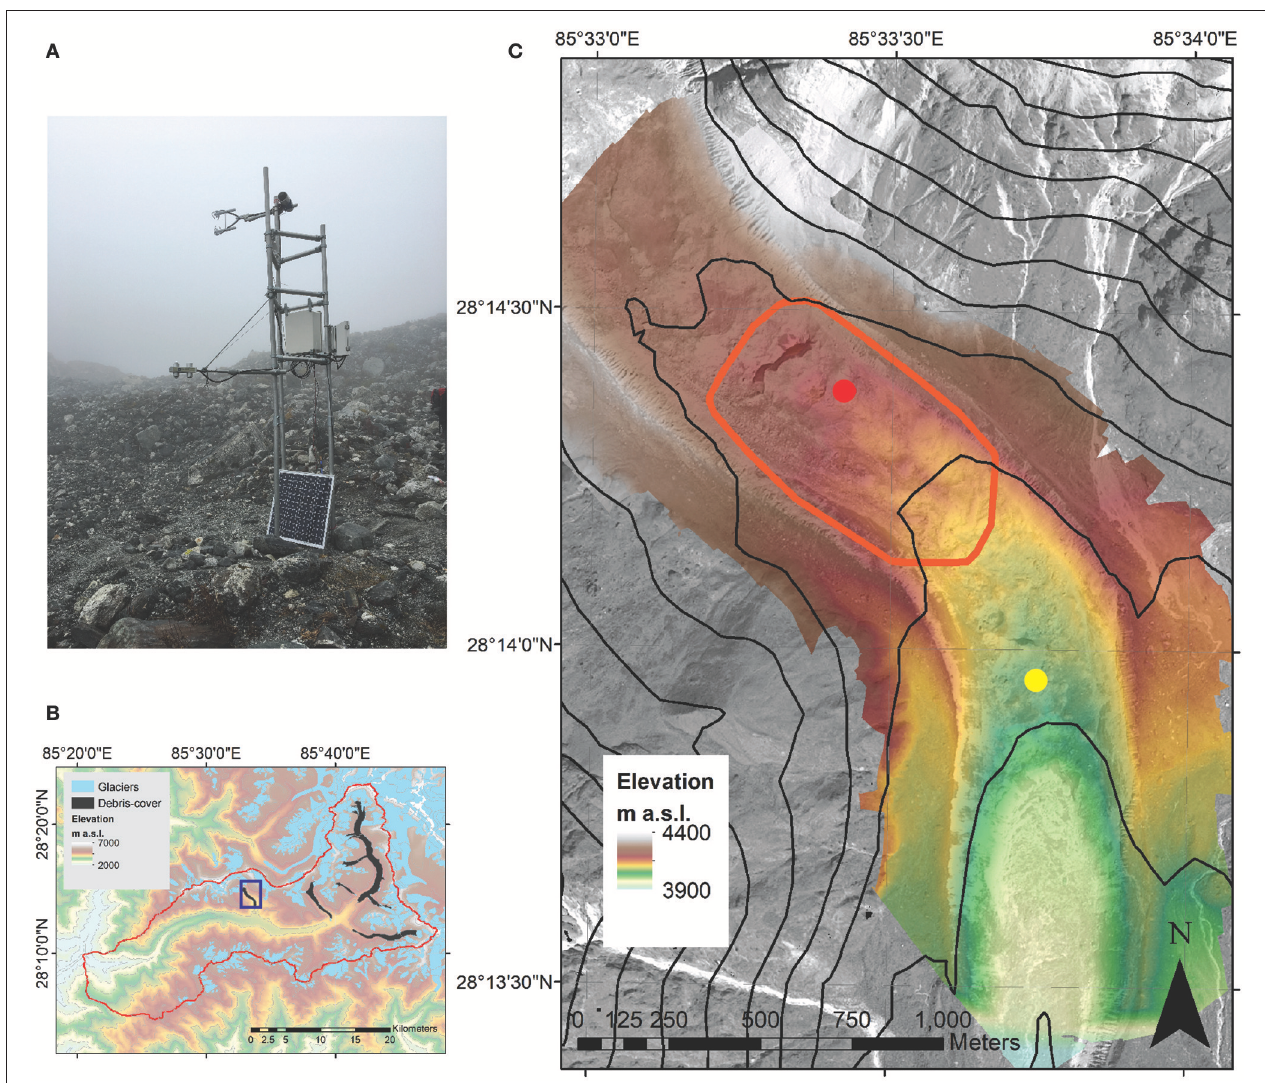
FIGURE 1 | (A) AWS setup including CNR1 radiation sensor and eddy correlation sensor. (B) Map of the Langtang catchment, with Lirung glacier marked. (C) Map of Lirung glacier showing the location of the AWS (red spot) and the approximate outline of the thermal flights carried out during the measurement period (red polygon). The glacier tongue DEM is based on data collected by an unmanned aerial vehicle on the same day as the thermal flights, the background image of the surrounding area is a satellite image (SPOT) from October 2015. The yellow dot marks the location of the AWS from which data for the season of 2014 was